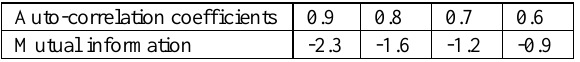
Table 1. Several auto-correlation coefficients and their corresponding reduced information amounts (unit: